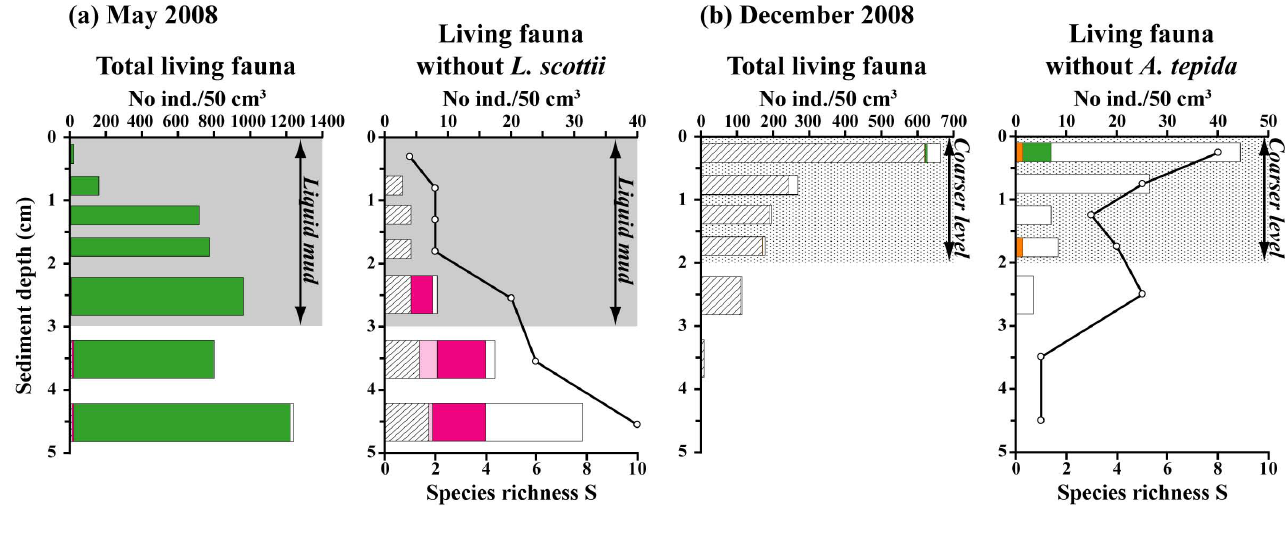
Fig. 11. Vertical distribution of the major taxa at Station A in May 2008 (a) and December 2008 (b) . On the right are represented the species richness S and the vertical distribution of the faunas without dominant taxa, i.e. without Leptohalysis scottii in May 2008 and without Ammonia tepida in December